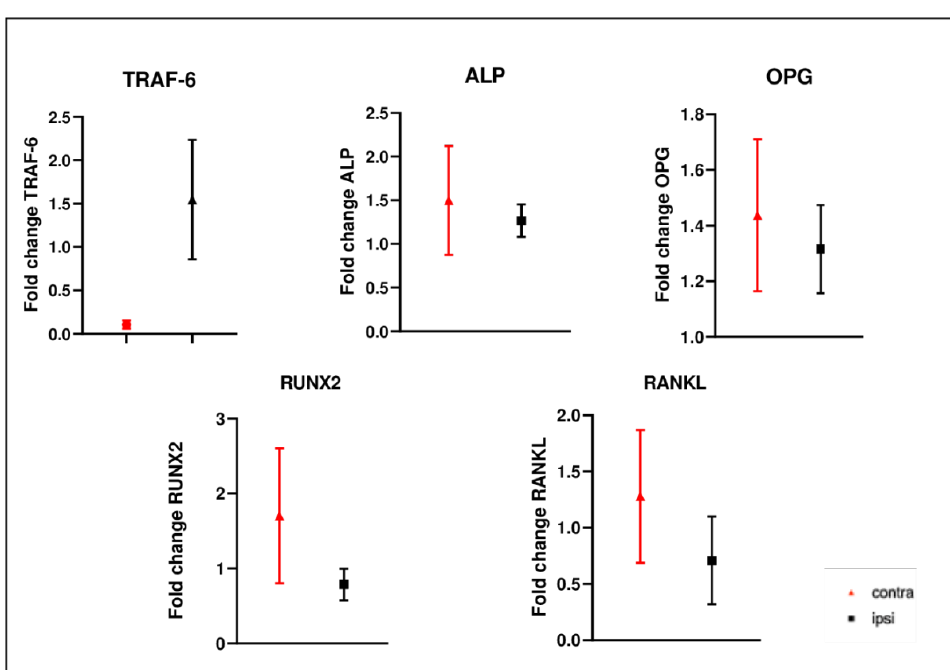
Figure 14. Results of real-time quantitative PCR in femurs. TRAF-6 gene expression was up-regulated in ipsilateral bone; instead, ALP , OPG , RUNX2 and RANKL gene expression were reduced. The results are presented as fold change. Fold change values were calculated as 2 ΔΔ Ct .